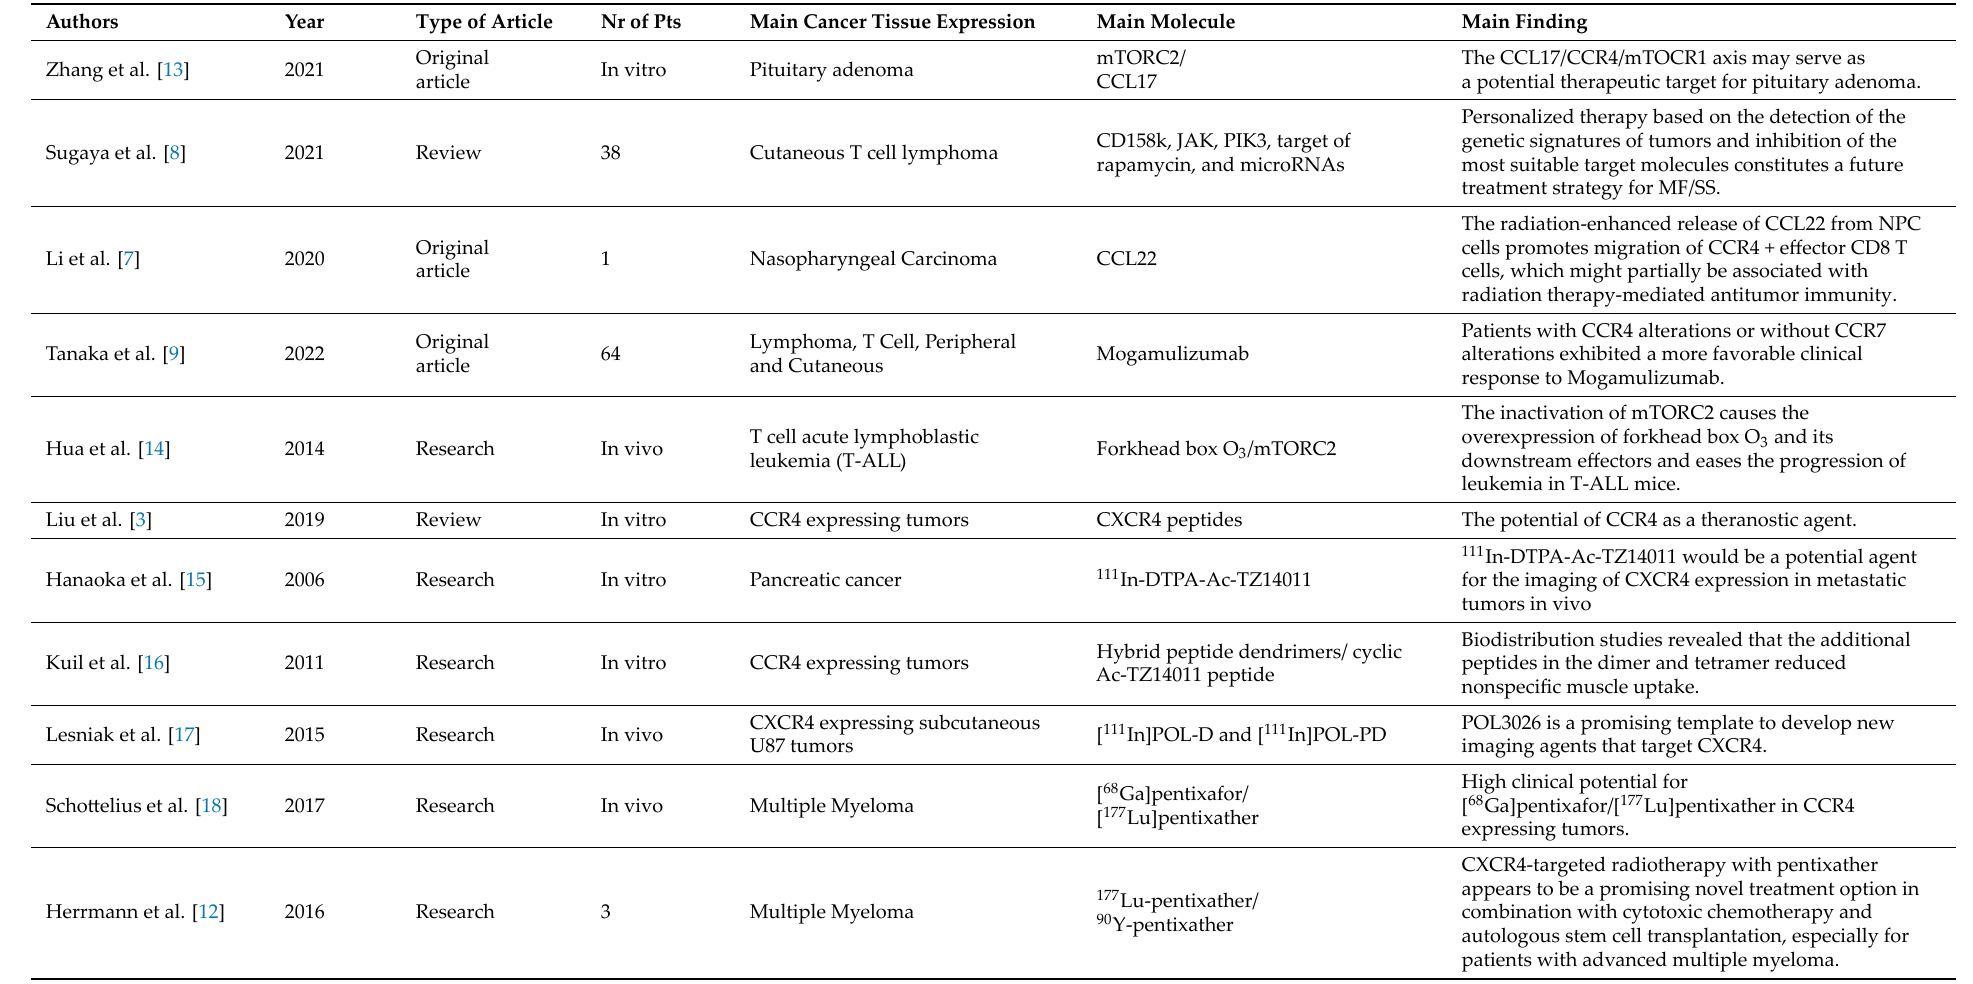
Table 2. Studies’